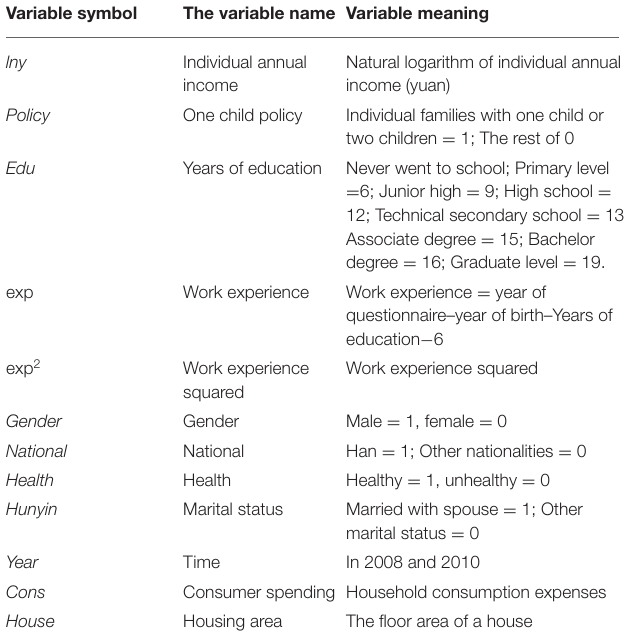
TABLE 2 | Description of variables. Variable